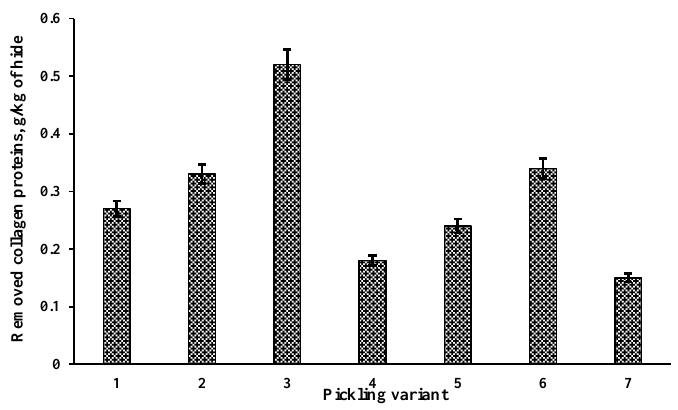
Figure 2. Effect of pickling method on collagen. Table 1. Influence of enzyme preparation addition on pickled pelt